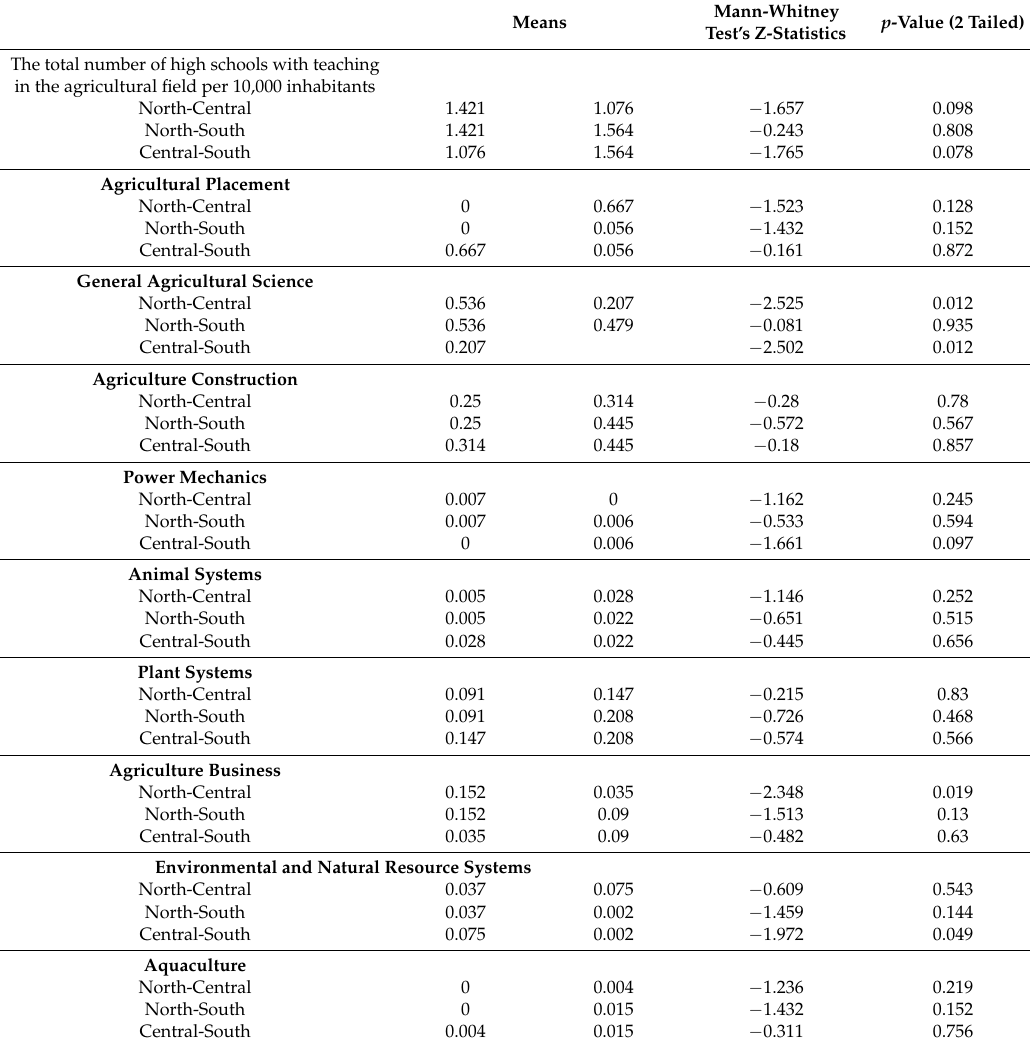
Table 5. A comparison of the average number of high schools with agriculture-related field learning (per 10,000 inhabitants) in Alabama’s northern, central, and southern regions.